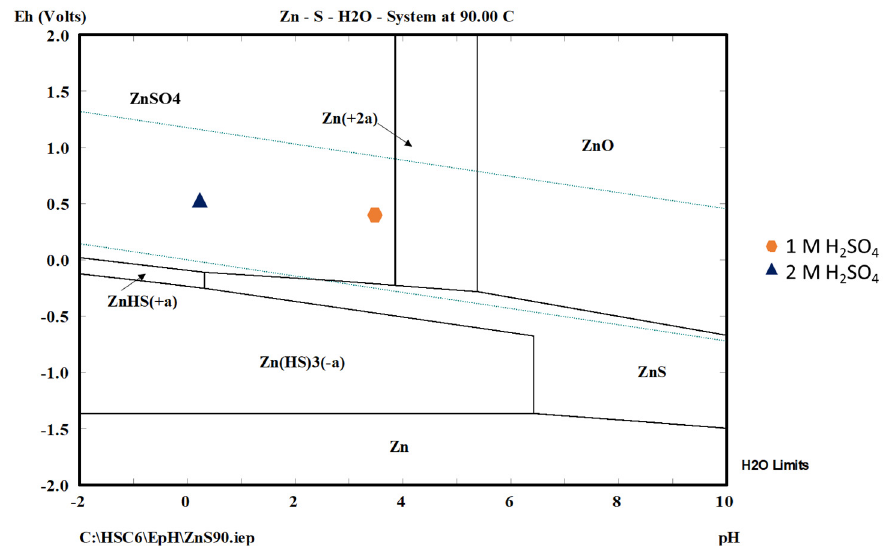
Figure 6. Pourbaix diagram for the Zn–S–H 2 O system at [Zn] = 0.005 M, 90 °C, and 0.55 MPa.